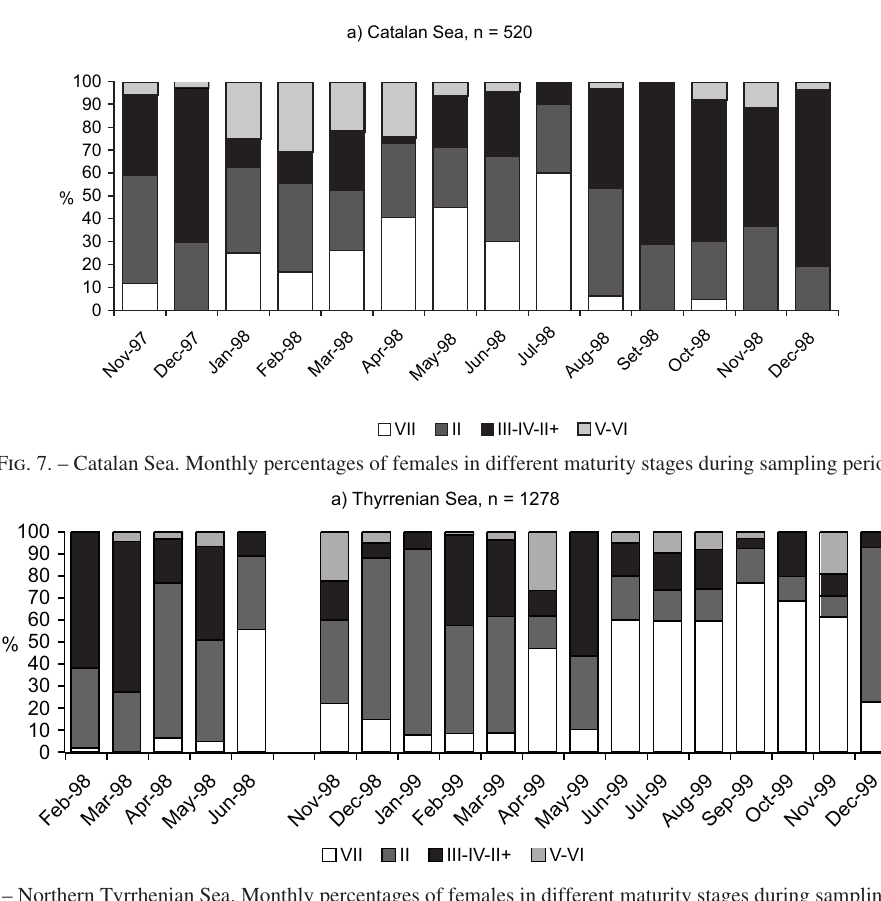
Fig . 8. – Northern Tyrrhenian Sea. Monthly percentages of females in different maturity stages during sampling period.